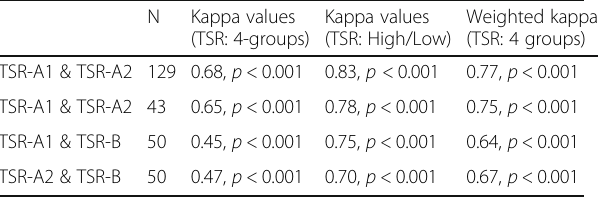
Comparison of stereological and semi-quantitative estimates of tumour stroma ratio